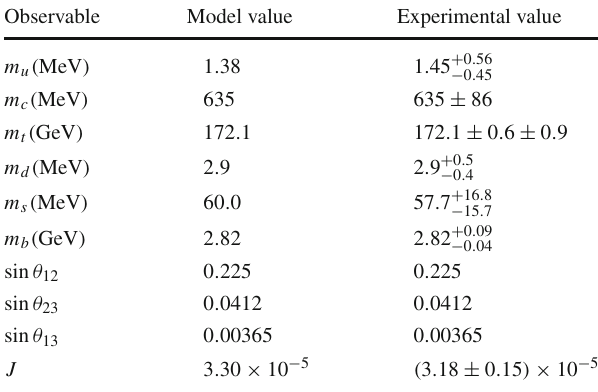
Table 5 Model and experimental values of the quark masses and CKM parameters Observable Model value Experimental